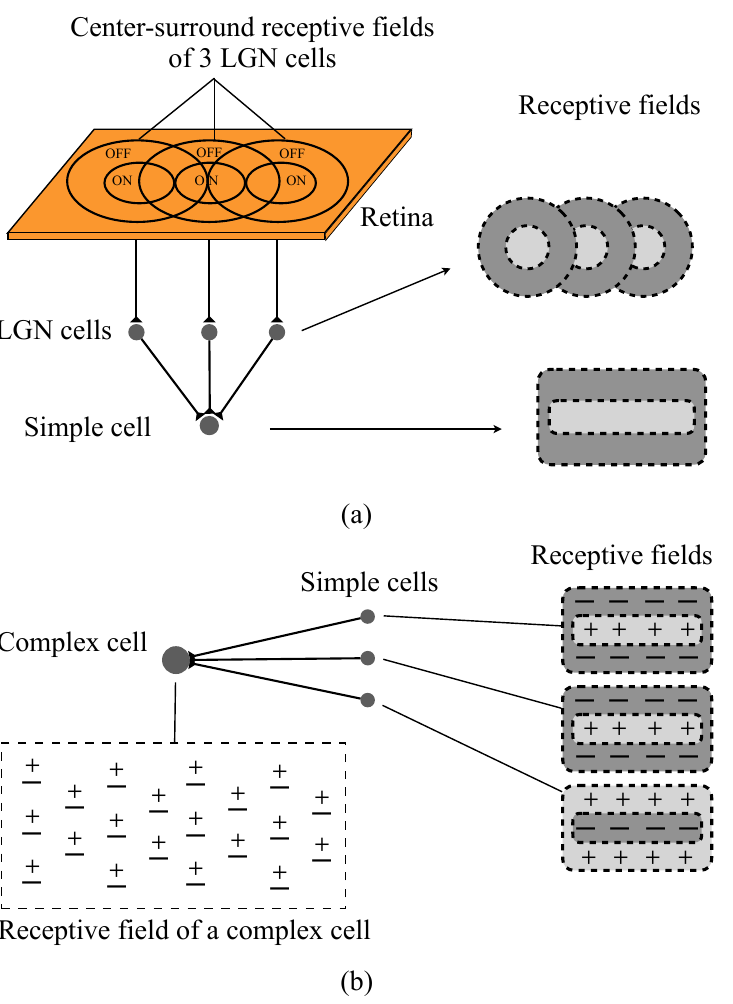
Figure 2. The convergent procession of simple cells’ and complex cells’ receptive fields. ( a ) A simple cell’s receptive field is formed by LGN cells’ spatially adjacent receptive fields. ( b ) Complex cell’s receptive field is an overlapping ON and OFF region which converged from simple cells’ receptive fields that with same orientation.“+”: ON region; “ − ”: OFF